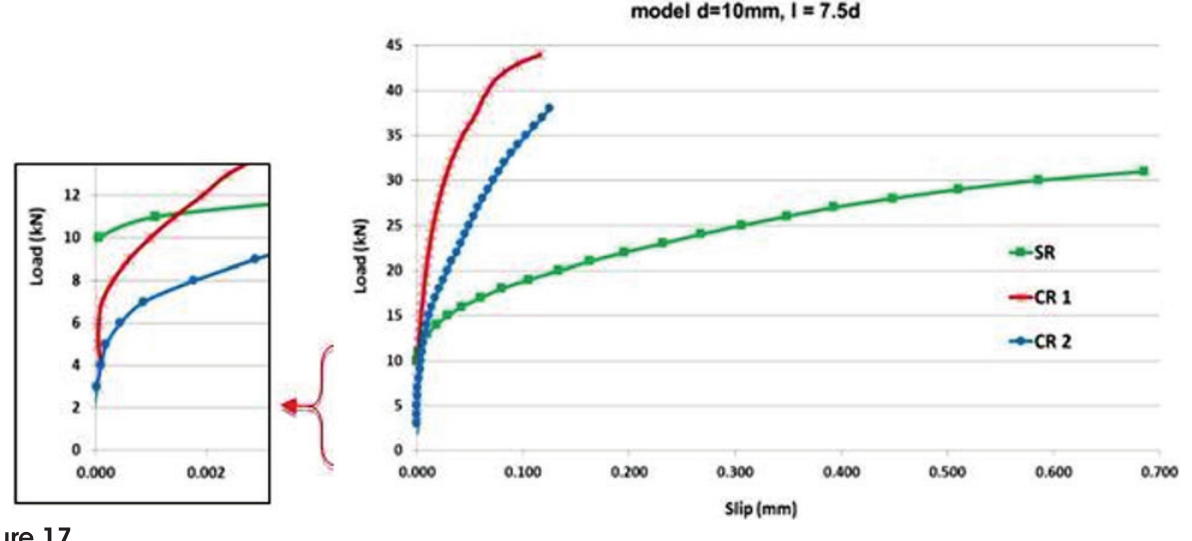
Figure 17 Load- slip, models: 10-7.5-0; 10-7.5-1;